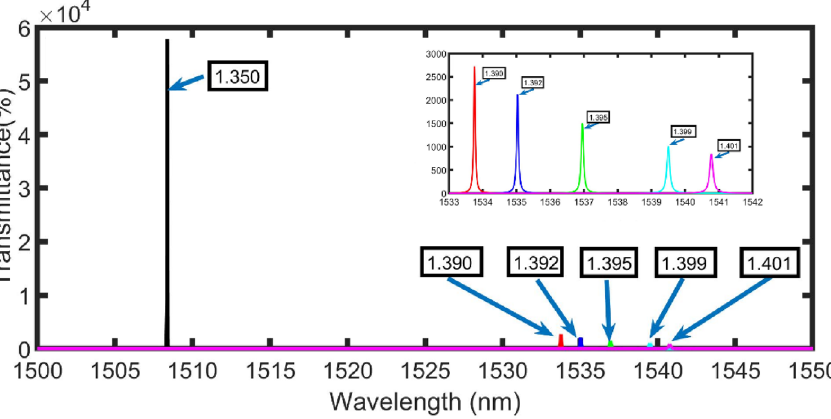
Figure 7. The transmittance of the proposed configuration at the selected conditions. The inset shows a zoom of the cancer cell